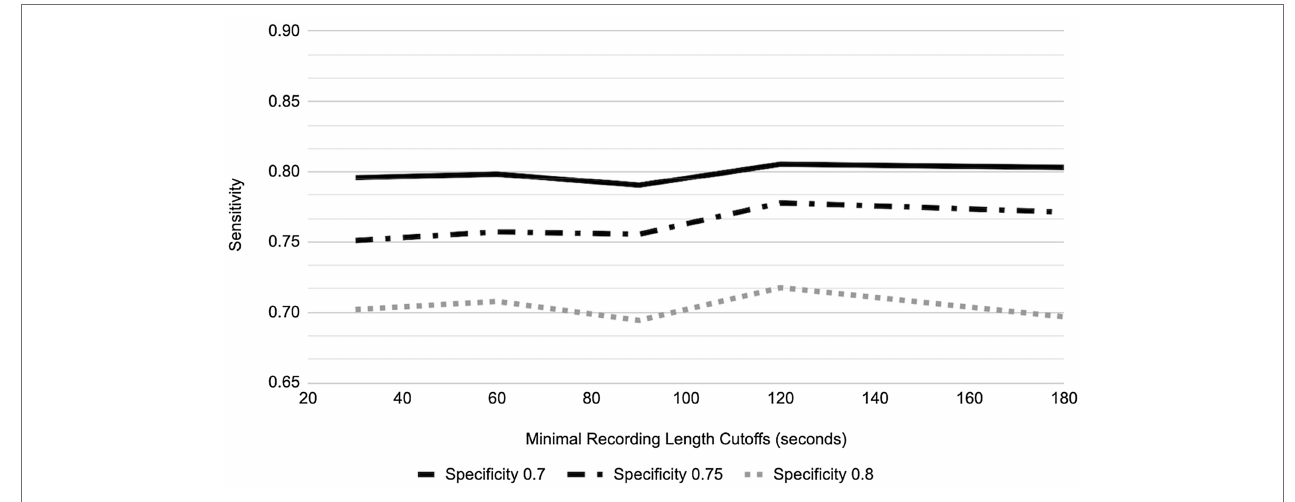
FIGURE 7 | Sensitivity vs. Specificity in relation to recording length cutoffs for